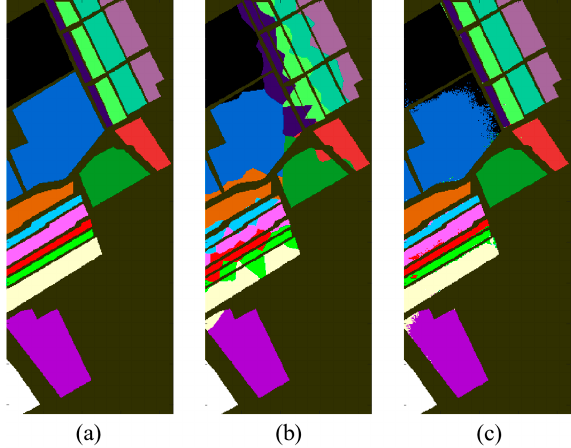
Figure 9. Classification result of SAL with 10 training samples per class (OA = 96.4%). ( a ) The ground truth of SAL. ( b ) The visualization of CASD’s effect. The intersecting lines between classes are badly drawn. ( c ) The final classification results of CASD assisted PCSSR. Most of errors are corrected in the SR process.